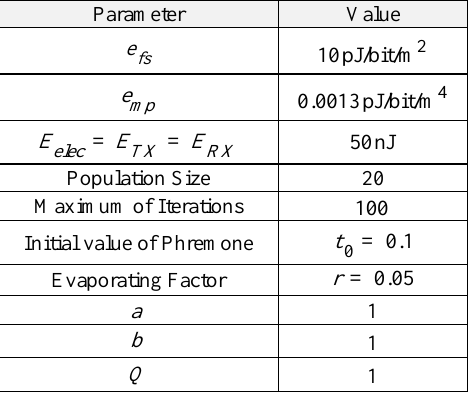
Table 1: Parameters used in energy